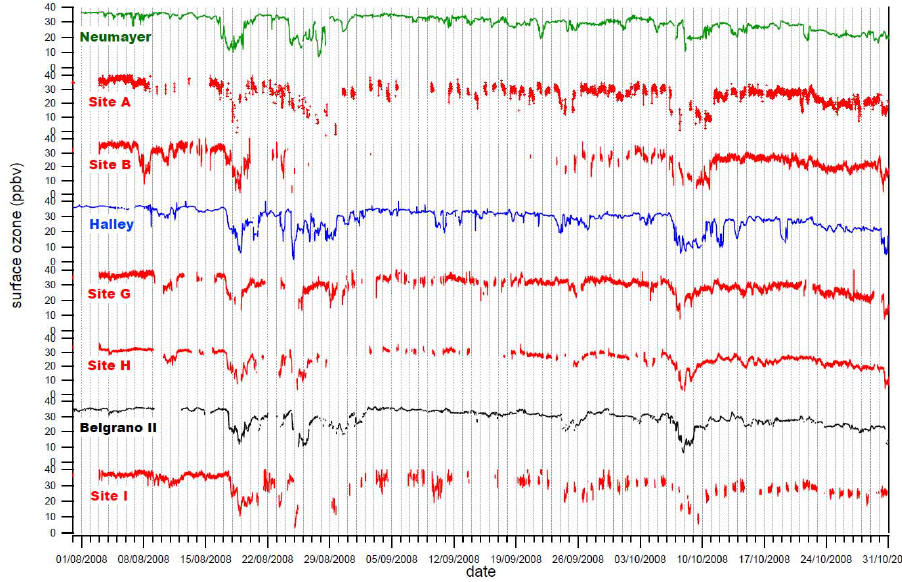
Fig. 2. Time-series of surface ozone measurements from the autonomous sites and manned stations that operated along the coast of the Figure 2. Time ‐ series of surface ozone measurements from the autonomous sites and manned 572 Weddell Sea, during the austral spring period 1 August to 31 October 2008. Tick marks denote midnight at the start of the stations that operated along the coast of the Weddell Sea, during the austral spring period 1 st August 573 to 31 st October 2008. Tick marks denote midnight at the start of the day. 574 575